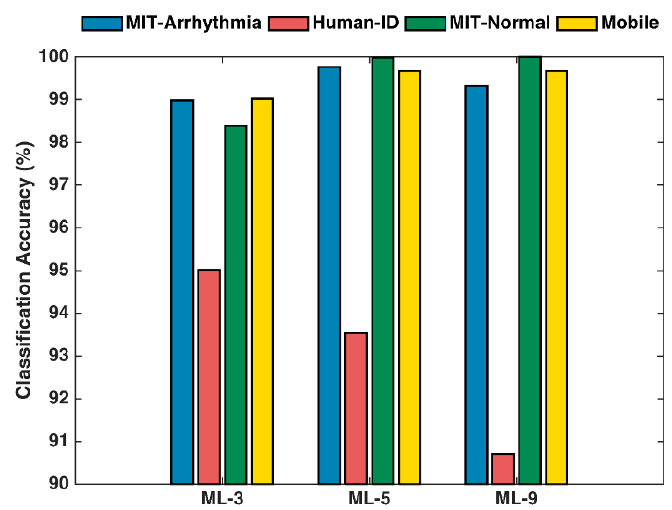
Figure 11. ECG biometric patient verification accuracy using random forest classifier only. ML-3 represents the features extracted from the Q, R, and S points; ML-5 represents the features extracted from the P, Q, R, S, and T points; and ML-9 further includes the wave boundaries P on , P off , T on , and T off (according to Table 2).